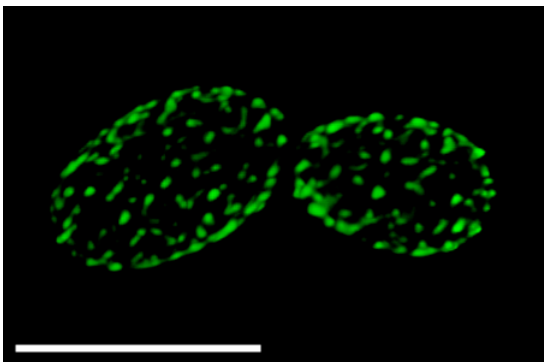
Figure 1. C. albicans Membrane Compartment of Can1 (MCC)/eisosome domains visualized with Sur7-GFP (Green Fluorescent Protein). C. albicans cells producing a Sur7-GFP fusion protein were analyzed by deconvolution of images taken by fluorescence microscopy. Note the presence of the punctate patches that correspond to the MCC/eisosome domains. Bar, 5 µm.